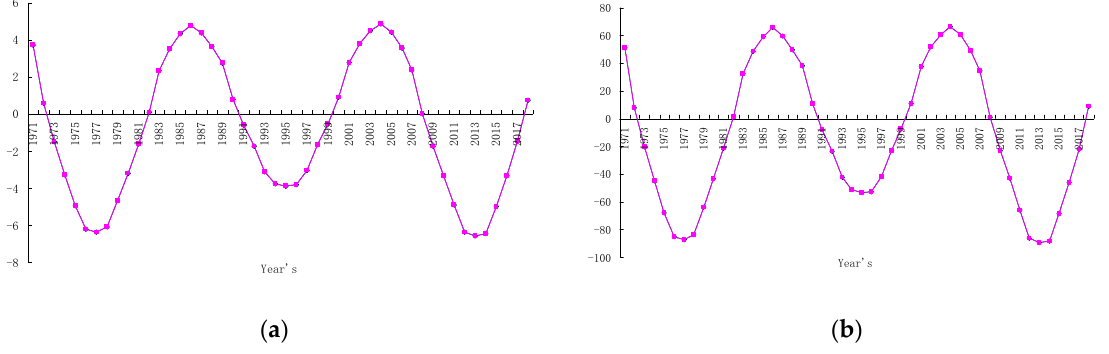
Figure 9. The characteristics of the first major cycle variations of the annual temperature ( a ) and annual precipitation ( b ) in the summer and autumn seasons in Fujian from 1971 to 2018.